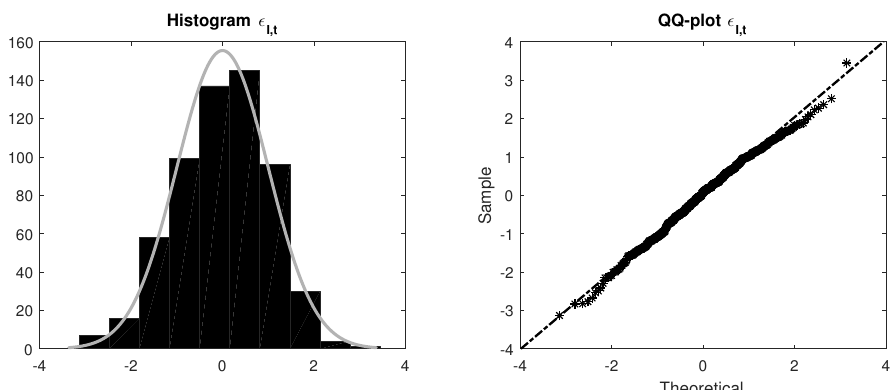
Figure 3. Histogram and QQ-plot of inflation index noise terms ε I , t . The inflation index noise terms ε I , t are extracted from the UKF using the parameters of Table